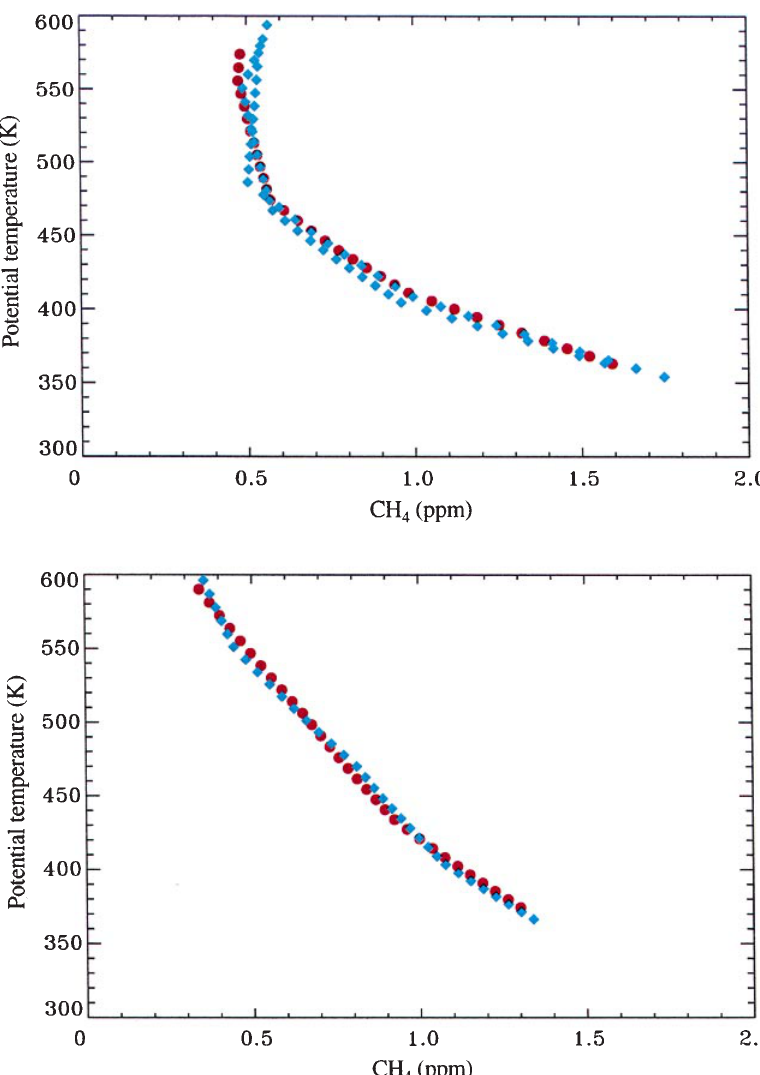
Fig. 12. Comparison of CH 4 vertical profiles observed at sunrise and sunset in the Arctic vortex. Top panel: observations on April 7, 1993 (uarsday 574); sunset observations (at 65.4 (cid:14) N, 11.2 (cid:14) E and 62.9 (cid:14) N, 105.8 (cid:14) E) are indicated by the cyan diamonds , sunrise observations (at 59.6 (cid:14) N, 353.2 (cid:14) E) are indicated by the red circles . Bottom panel : observations on April 2, 1994 (uarsday 934), sunset observations at 56.4 (cid:14) N, 288.9 (cid:14) E ( cyan diamonds ) and sunrise observations at 55.2 (cid:14) N, 282.6 (cid:14) E ( red